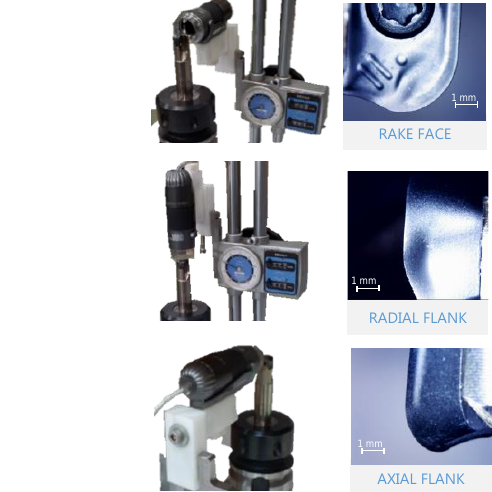
Figure 8. Areas of 3D surface measurement on inserts.